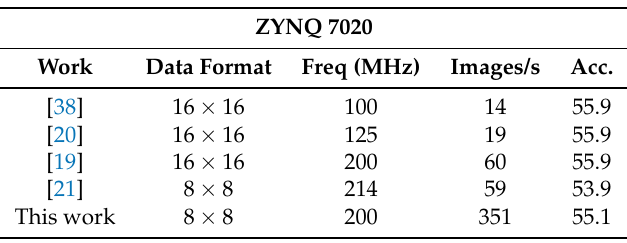
Table 2. Performance comparison of the proposed architecture with previous works running AlexNet in the low density FPGA